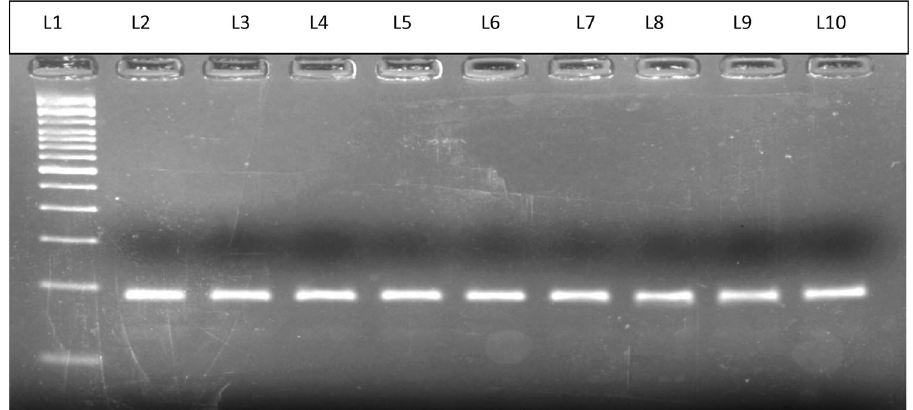
Figure 2. Representative picture of PCR amplification of CYP19 gene. L1 represents 100 bp ladder; L2–L10 show amplified 189 bp PCR product.